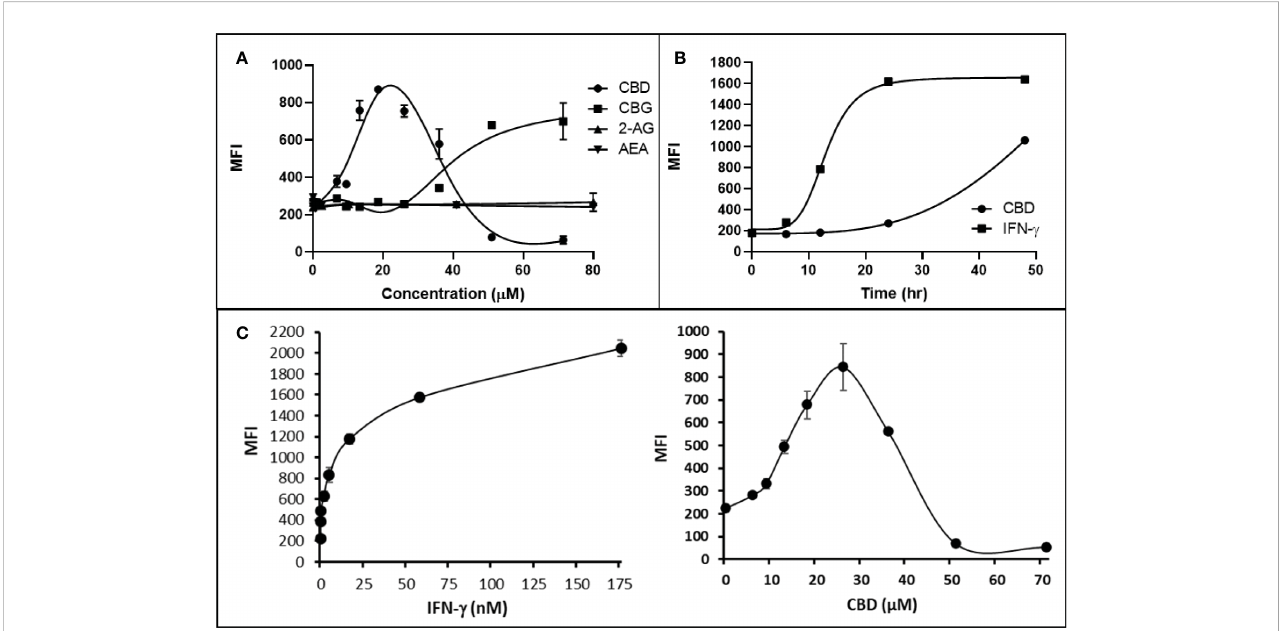
FIGURE 4 Phytocannabinoids, but not endocannabinoids, induce MHC-I expression in a dose- and time-dependent manner. (A) The endocannabinoids 2-AG and AEA had no effect on MHC-I expression in COLO 205 cells as determined by fl ow cytometry, in contrast to the activity of the phytocannabinoids CBD and CBG after 48 hr of treatment. (B) An MHC-I induction time course shows that elevated MHC-I is fi rst detectable at 24 hr in cultured COLO 205 cells treated with 15 µM CBD but has reached maximum expression by 24 hr in cells treated with 3 ng/ml IFN- g . (C) . Parallel dose titrations spotlight the dramatic impact of IFN- g and CBD on MHC-I expression in COLO 205 cells. The titrations also clarify differences in potency and dose effect between the cytokine and the cannabinoid. The dose titrations were conducted in triplicate in the same experiment and are representative of numerous IFN- g and CBD comparisons. Statistical analysis using a two-sided T-test with unequal variances revealed that every titration data point has a p-value of less than 0.005 vs. the untreated sample. MFI: mean fl uorescent